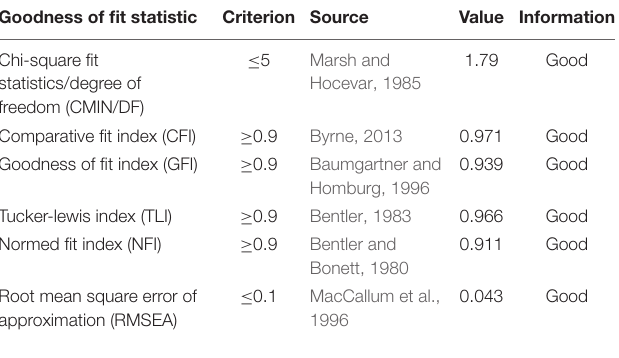
TABLE 3 | Goodness-of-fit statistics of the measurement model.